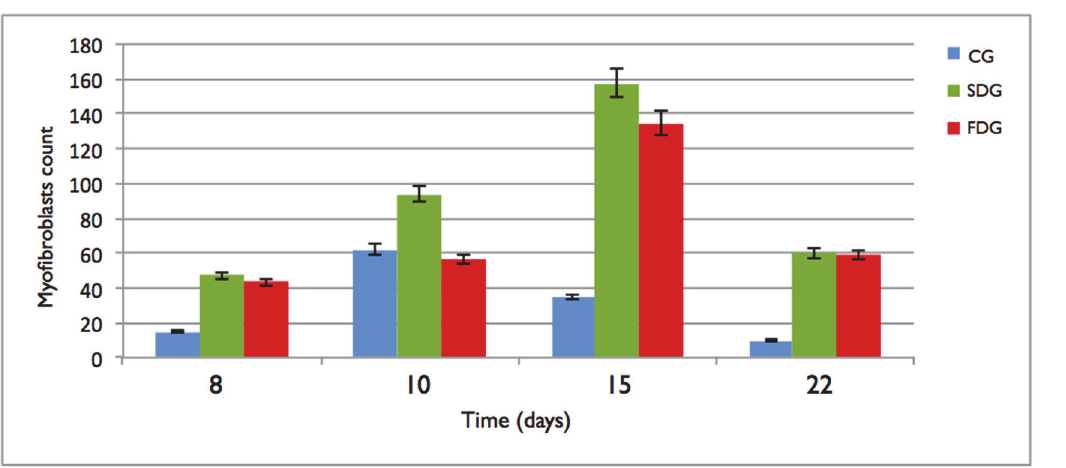
Fig 6. Myofibroblast count showing more cells in both laser groups on Days 8, 15 and 22 in comparison to control; SDG exhibited more myofibroblasts than other groups on Days 10 and 15. Bars represent mean counts with respective standard deviation